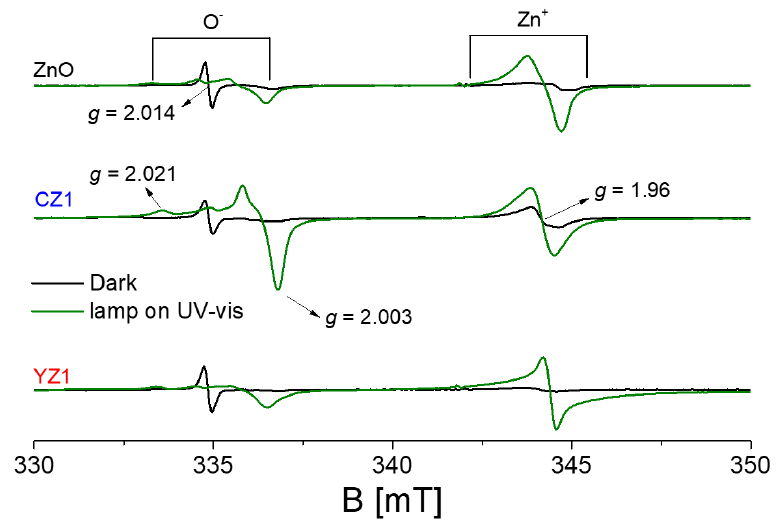
Figure 3. EPR spectra recorded ad 77 K after the activation treatment and before irradiation of ZnO, CZ1 and YZ1. Spectra in black: samples in dark. Green spectra: upon is-situ irradiation with UV-vis light at 1000 W.